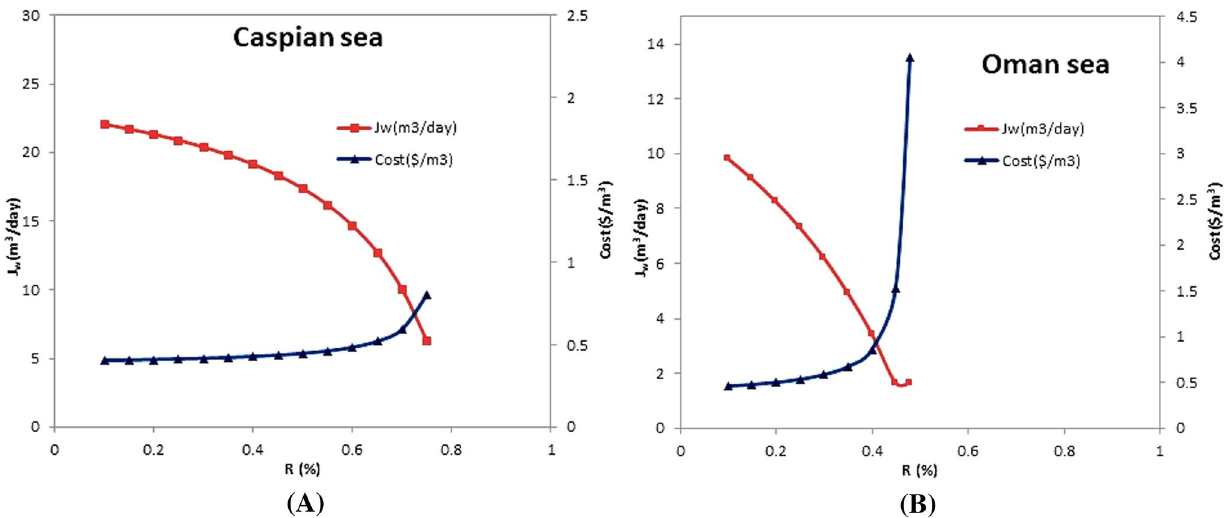
Fig.5 Evaluating the effect of the recovery ratio on the cost and the permeate flow rate (Δ P = 45 bar, T = 25 °C)